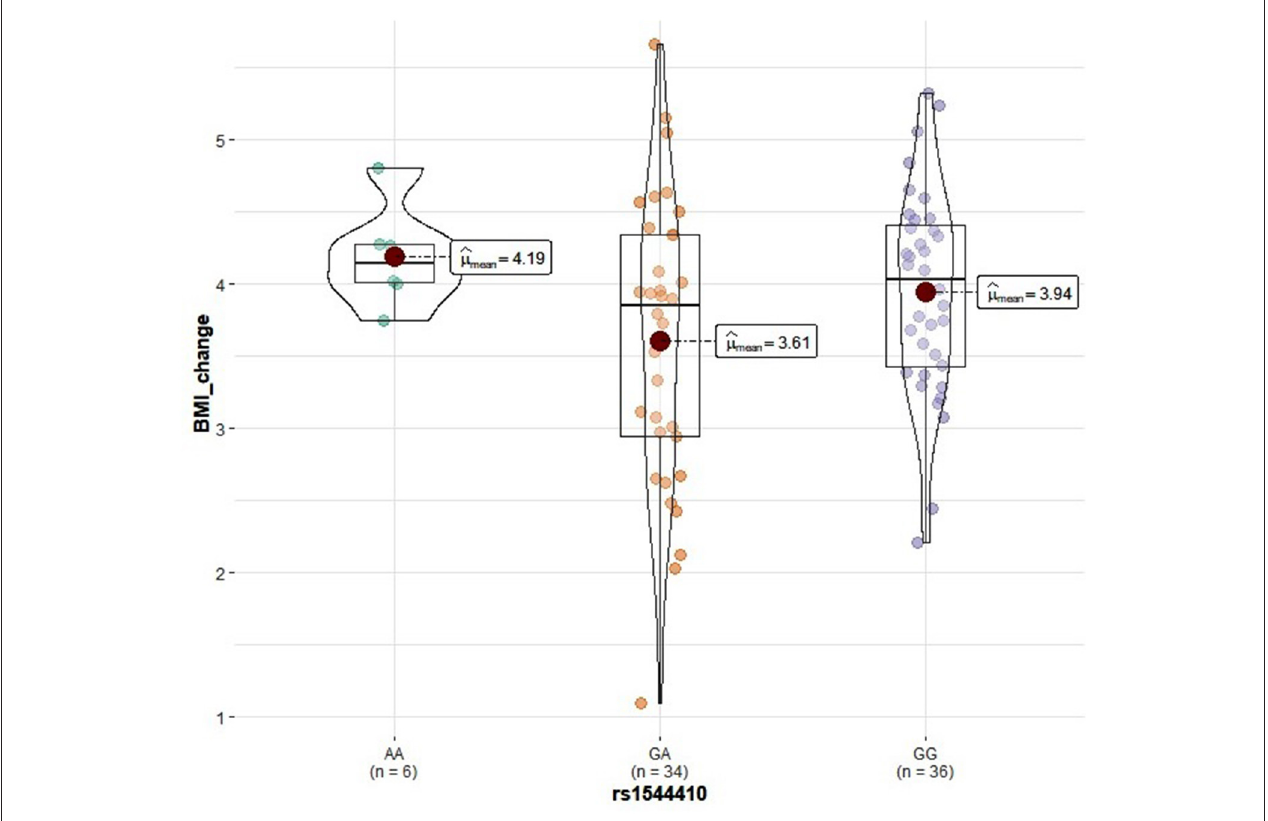
FIGURE 6 | Violin plots displaying the mean values of BMI change before and after the intervention in the control group according to rs1544410 genotype